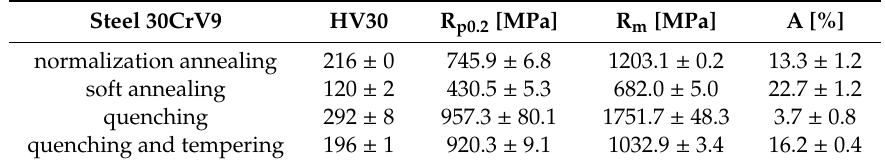
Table 8. Vickers hardness HV30, proof strength R p0.2 [MPa], ultimate tensile strength R m [MPa], percentage elongation after fracture A [%].